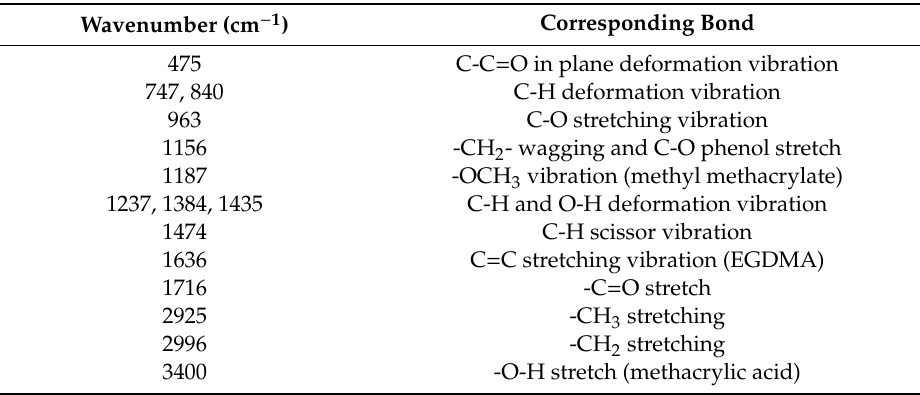
Table 1. FT-IR peak analysis.